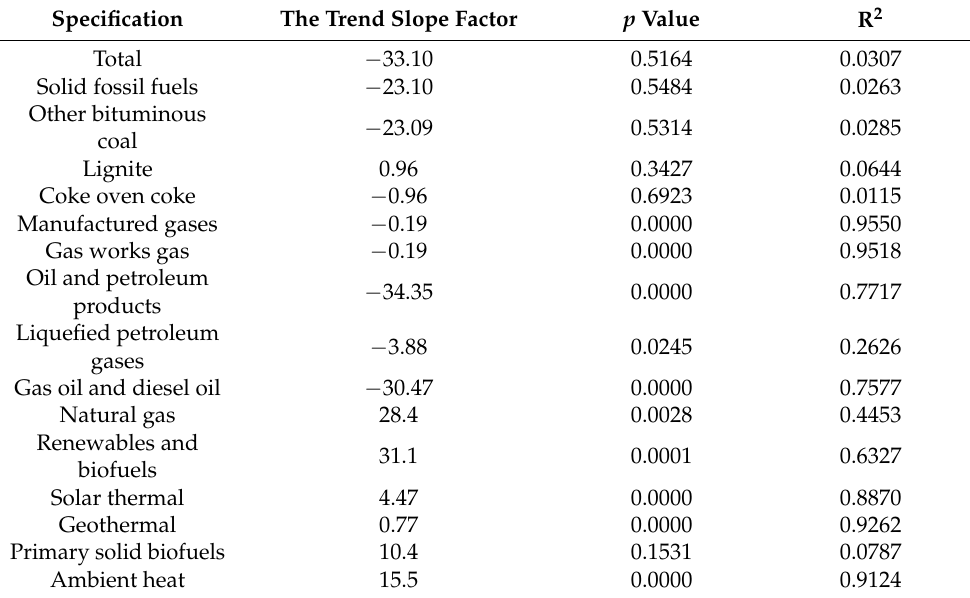
Table 4. Trends in the use of energy sources in Polish households in